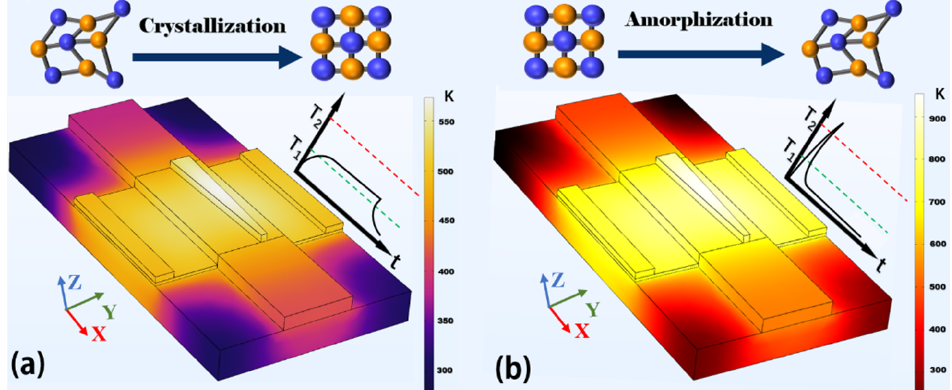
Figure 10. Electric-thermal simulation for the proposed reconfigurable mode converter. The phase state of Sb 2 Se 3 material changes ( a ) from the amorphous state to the crystalline state and ( b ) from the crystalline state to the amorphous state, respectively. T 1 and T 2 stand for the phase transition temperature and melting temperature of Sb 2 Se 3 , respectively. The upper temperature limit of the proposed device is 1100 K.